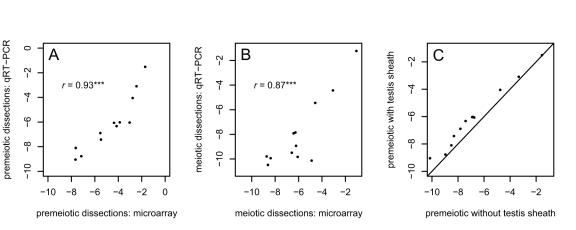
qRT-PCR analysis indicates the contaminating effect of testis sheath has a detectable effect on gene expression.(A & B) qRT-PCR results for 12 genes from premeiotic and meiotic dissections show good correspondence with previously published microarray results [41]. (C) Apical dissections (premeiotic cells) including the testis sheath show slight but detectable increases in the expression of X-linked genes relative to apical dissections from which the sheath has been removed. *** p<0.001.